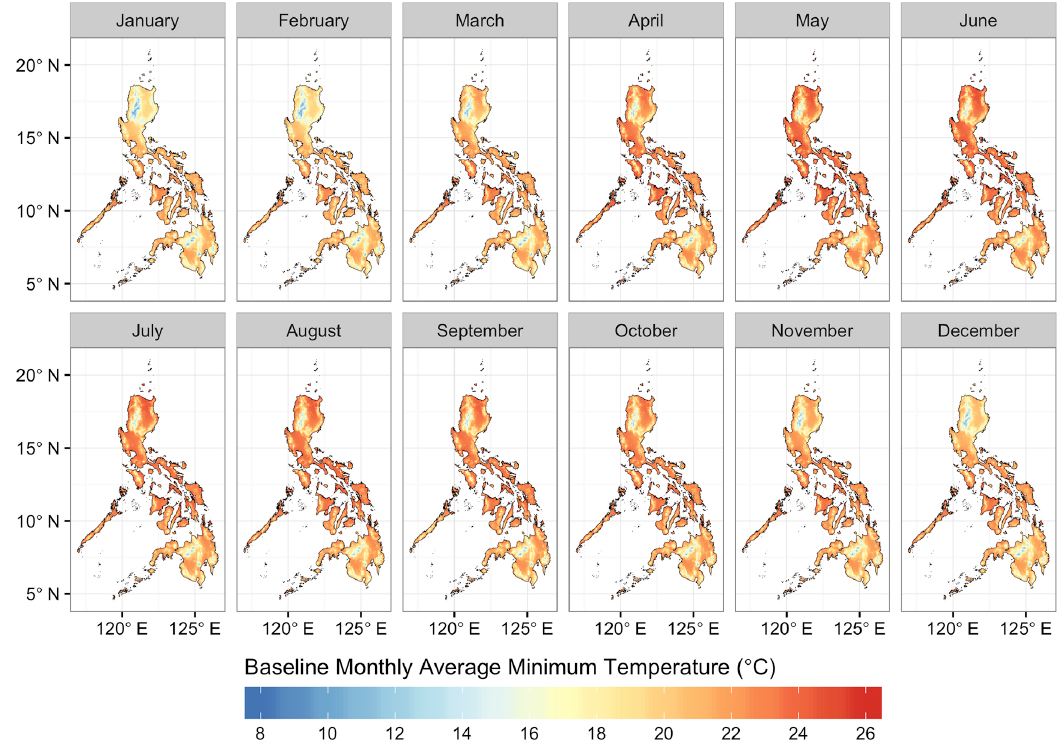
Fig. 4. Spatial distribution of average minimum monthly temperature in the Philippines under baseline climate condition (1950–2000).